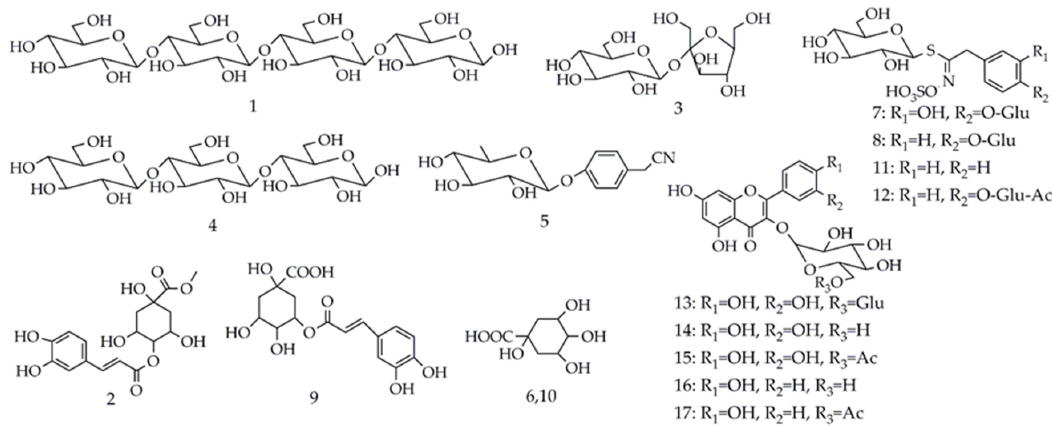
Figure 3. The molecular structures of all detected compounds in extracts of leaves, seeds and roots of M. oleifera . Glu: Glucoside; Ac: Acetyl.